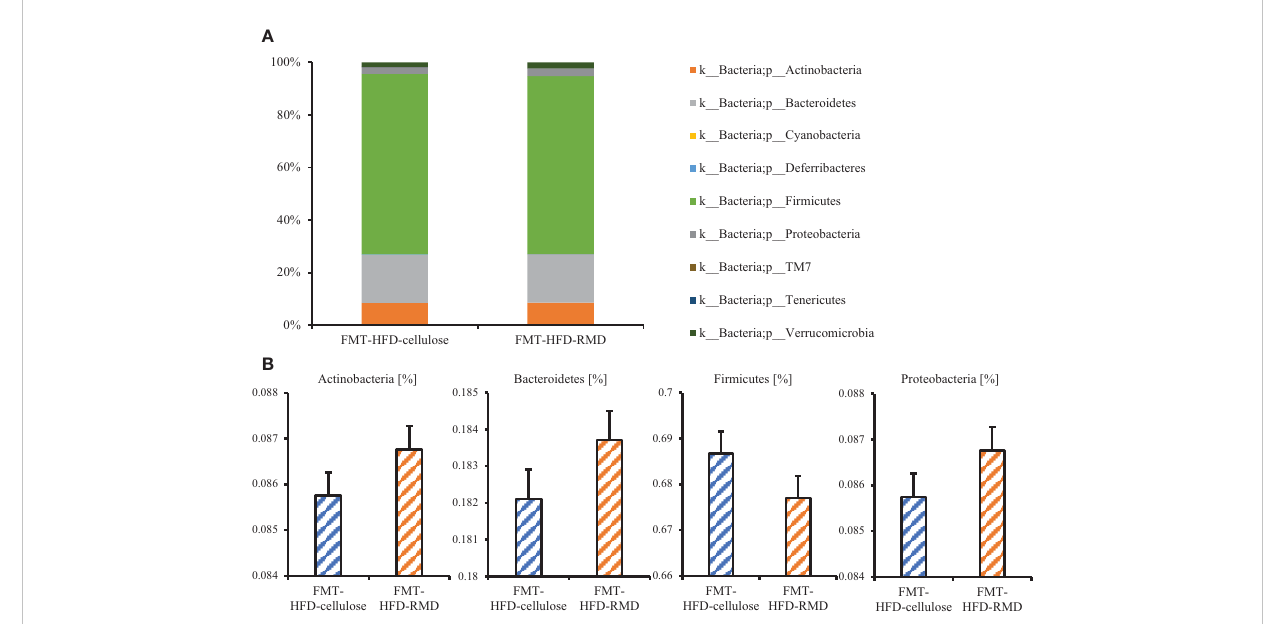
FIGURE 8 The gut microbiota component in the FMT-HFD-cellulose and -FMT-HFD-RMD groups. (A) Gut microbiota composition and (B) relative bacterial abundance at phylum level in FMT-HFD-cellulose and FMT-HFD-RMD groups 2 days after the FMT. All data are shown as means ± SEM (n =